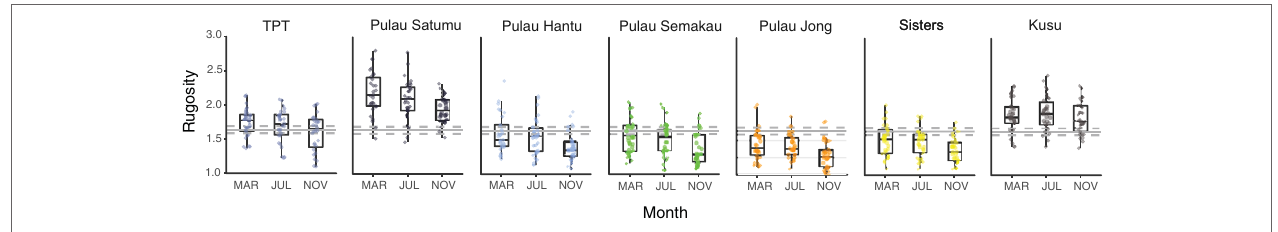
FIGURE 3 | Box plots showing variation in small-scale rugosity among Singapore reefs in March, July and November 2016. Solid grey horizontal lines represent mean rugosity across all reefs, with dashed lines representing 95% confidence intervals over the entire study period. Rugosity estimates for each reef are based on 30 measurements each survey